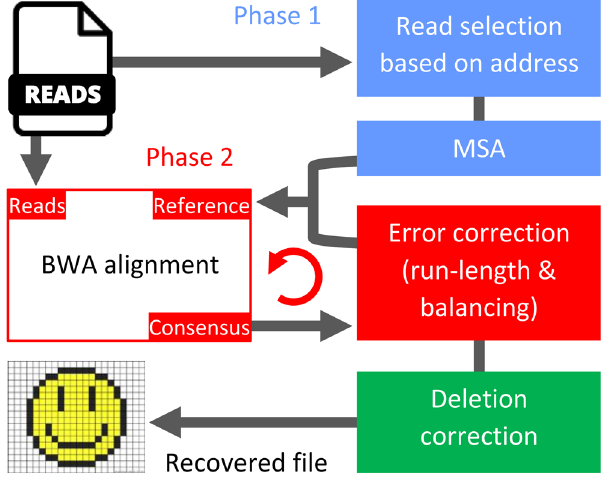
Figure 2. Post processing via sequence alignment and homopolymer correction. In the first phase, estimates of the DNA codewords are obtained by running several MSA algorithms on high-quality reads that contain an exact match with the address sequence. The second phase improves the estimate by employing an iterative method that includes BWA alignment and an errorcorrecting